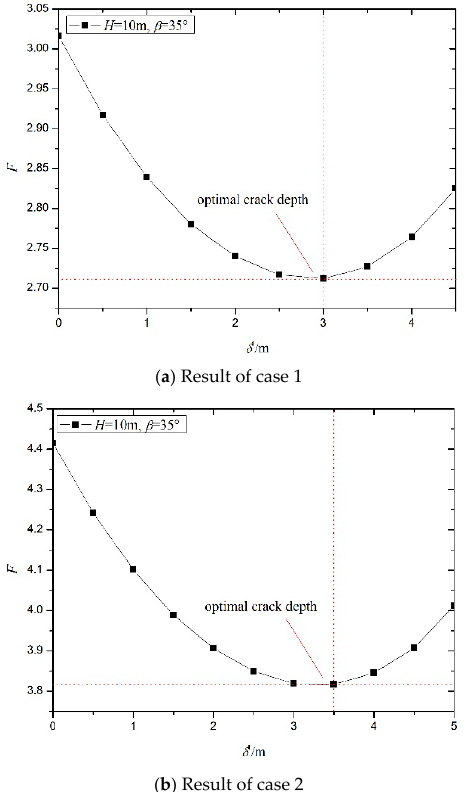
Figure 10. Relationship between safety factor and crack depth under low slope height.